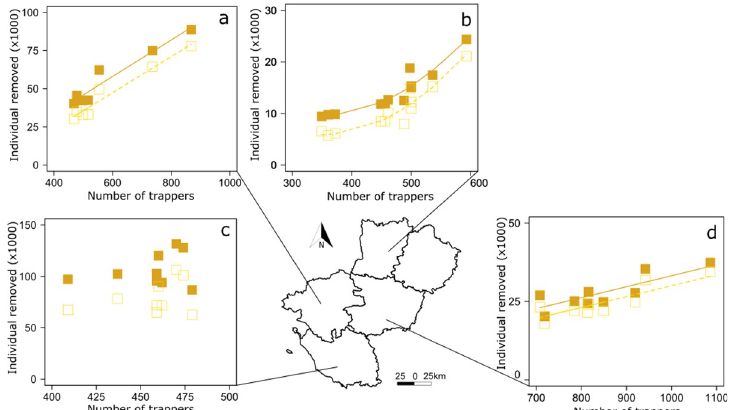
Fig 6. Variation of the number of aquatic invasive alien rodents (AIAR) with the number of trappers in the 5 departments of the region Pays de la Loire. AIAR (full square) and coypus only (open square) removed in (a) Loire- Atlantique, (b) Mayenne, (c) Vende´e, and (d) Maine-et-Loire. Data in Sarthe were not available. Curved lines represent significant trends from generalized least squares (GLS) models with an autoregressive moving average term (see S3 Table for statistical details). Source of the background map: IGN GEOFLA 1 . individuals per year in the region Pays de la Loire. In regards to the departments, the same assessment in 2016 (except Sarthe) highlighted that the number of AIAR (and coypus in brack- ets) removed per trapper reached about 280 (226) in Vende´e, 102 (90) in Loire-Atlantique, 35 (32) in Maine-et-Loire, and 30 (24) in Mayenne (S1 Table). Although we did not detect a sig- nificant change over time in the total number of AIAR removed per trapper at the regional level, the number of coypus removed per trapper increased by 22% over time (Fig 2C, S2 Table). Analyses showed that the number of AIAR or coypus only removed per trapper increased with time in at least 3 departments (Mayenne (Fig 7B), Vende´e (Fig 7C) and Loire- Atlantique (Fig 7A) with the two former showing a curvilinear trend, see S2 Table). Although we detected a curvilinear variation in the number of trappers over time in Maine-et-Loire (Fig similar in 2008 and 2016.